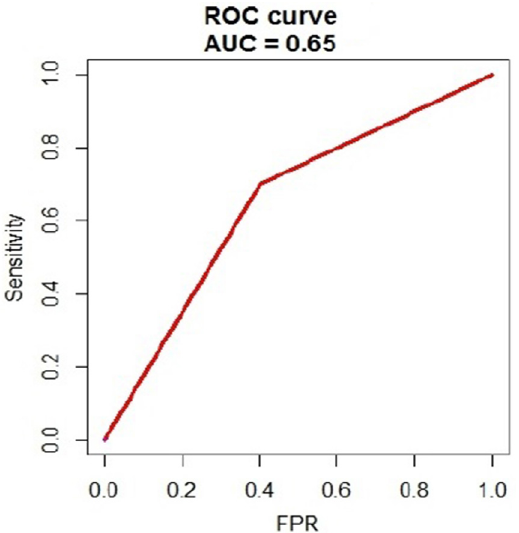
Fig. 5. ROC curves of the proposed method after applying the gene selection process for sample size of 20.